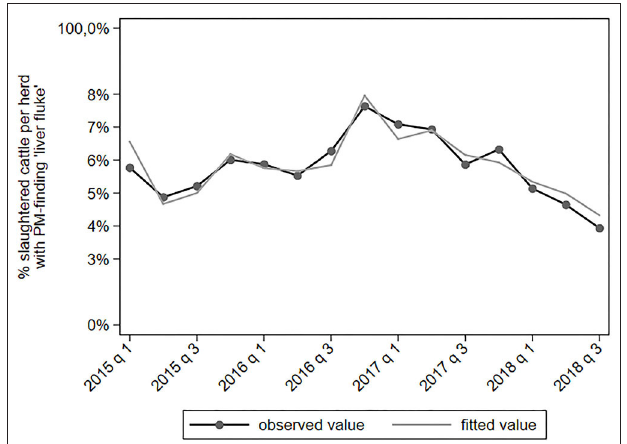
FIGURE 8 | Observed and predicted percentage of slaughtered cattle per dairy herd with a PM-finding categorized under “round/buttock region,” per quarter between January 2015 to September 2018 ( N =